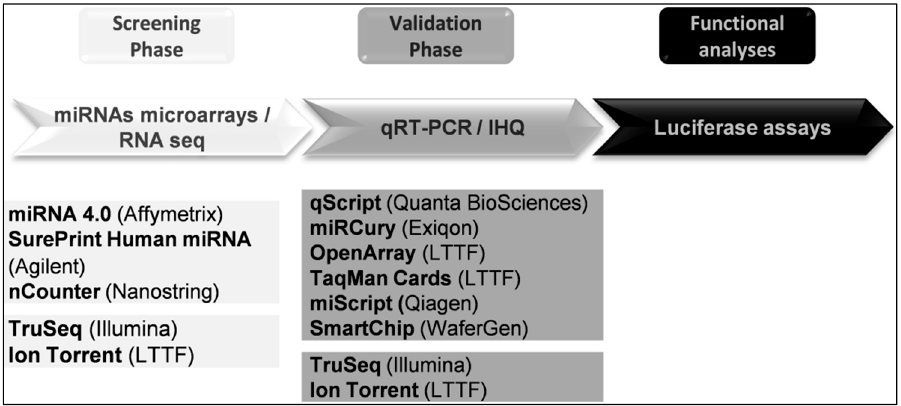
Figure 2. Workflow in a classical study on miRNAs.